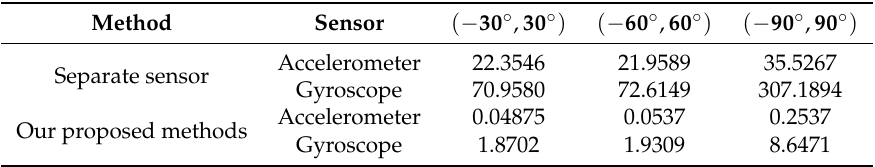
Table 2. Calculation bias of the sensing information by using difference